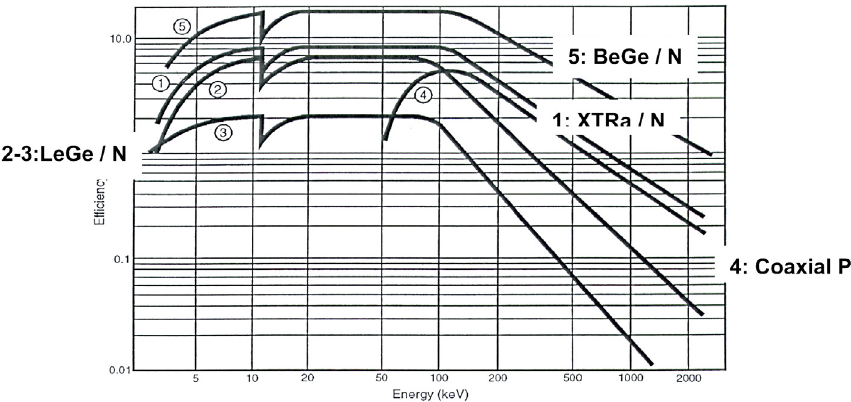
Fig. 5. Efficiency of the different kinds of gamma-X detectors.